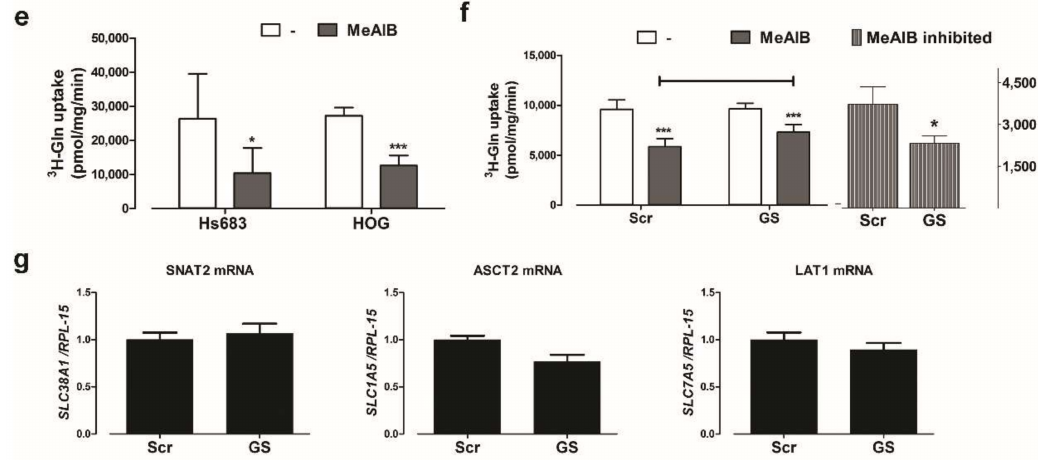
Figure 7. Human OD cells transport Gln through several carriers ( a ) SLC38A2, SLC1A5 and SLC7A5 mRNA expression was assessed in Hs683 and HOG cells. Data were normalized to the expression of RPL-15 . ( b ) Western blot of SNAT2, ASCT2 and LAT1 in Hs683 and HOG cells. GADPH was used as loading control. ( c ) Immunofluorescence of ASCT2 (red) in Hs683 and HOG cells. β -catenin (green) was used as a marker of cell periphery. ( d ) 1-Min uptake of Gln (0.6 mM, 5 µ Ci/mL) performed in EBSS in the absence (Control) or in the presence of MeAIB (20 mM), threonine (Thr, 5 mM), or in Na + -free EBSS (-Na + ). ( e ) 1-Min uptake of Gln (2 mM, 5 µ Ci/mL) performed in Hs683 and HOG cells pre-incubated in Gln-free EBSS for 30 min. Gln uptake was performed in the absence or in the presence of MeAIB (20 mM). ( f ) 1-Min uptake of Gln (2 mM, 5 µ Ci/mL) was performed in Hs683 cells transfected with pCMV- GLUL vector (GS) or a scramble control (Scr) incubated after a 30 min incubation in Gln-free EBSS. Gln uptake was performed in the absence or in the presence of MeAIB (20 mM). ( right ) MeAIB-inhibited fraction was calculated by subtracting the uptake in the presence of MeAIB to the corresponding total Gln uptake. ( g ) SLC38A2, SLC1A5 and SLC7A5 mRNA expression was assessed in scramble (Scr)- and GLUL -transfected (GS) Hs683 cells. Data were normalized to the expression of RPL-15 . For ( a , g ), means ± SD of three experiments are shown. ** p < 0.01, *** p < 0.001, as assessed with two-tail student t test. For ( d – f ), data are expressed as pmol/mg prot/min and are means ± SD of three (for ( d , e )) or two (for ( f )) experiments, with five independent determinations each. For ( d , e ), ** p < 0.01, *** p < 0.001, ns, not significant, as assessed with two-tail student t test; for ( f ), ** p < 0.01, as assessed with two-way